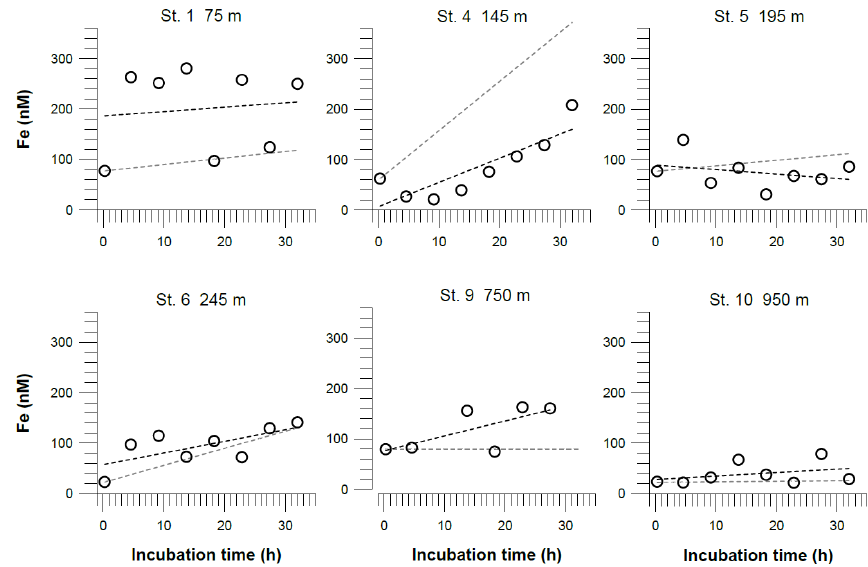
Figure 5. Dissolved Fe concentrations in incubated bottom waters from benthic chamber incubations. The black dashed line represents the linear regressions of the concentration change over the incubation time. The equations for these linear regressions are listed along with the coefficients of determination ( R 2 ) in Table S4. The gray dashed line represents theoretical concentration gradients over the incubation time based on our benthic diffusive fluxes (Table 2). The analytical error is smaller than the symbol